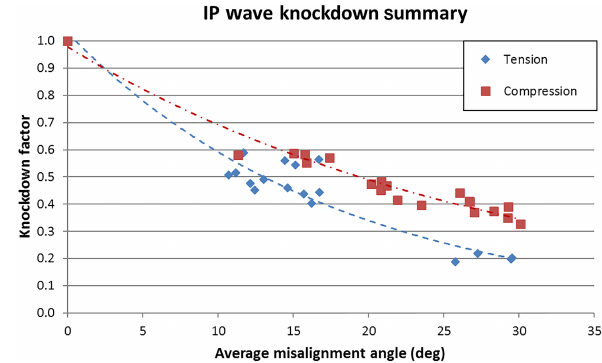
Figure 4. Empirically derived knockdown factor as related to fiber misalignment